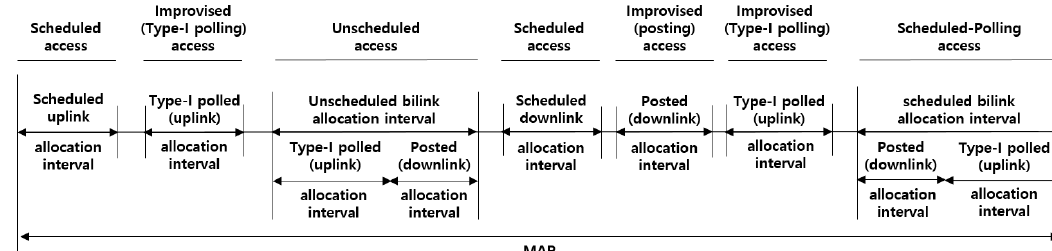
Figure 4. Allocation intervals and access methods in a managed access phase (MAP).